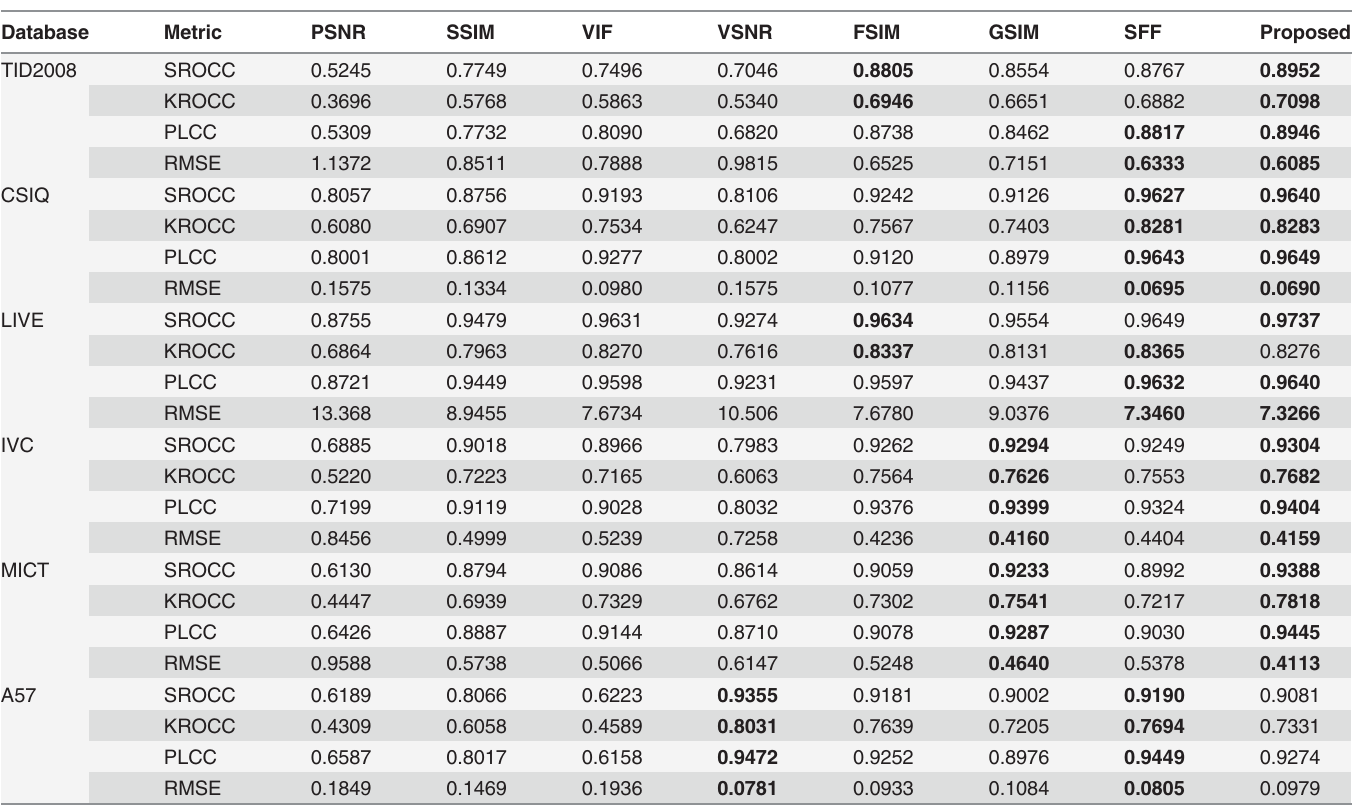
Table 2. Overall performance comparison for IQA schemes.